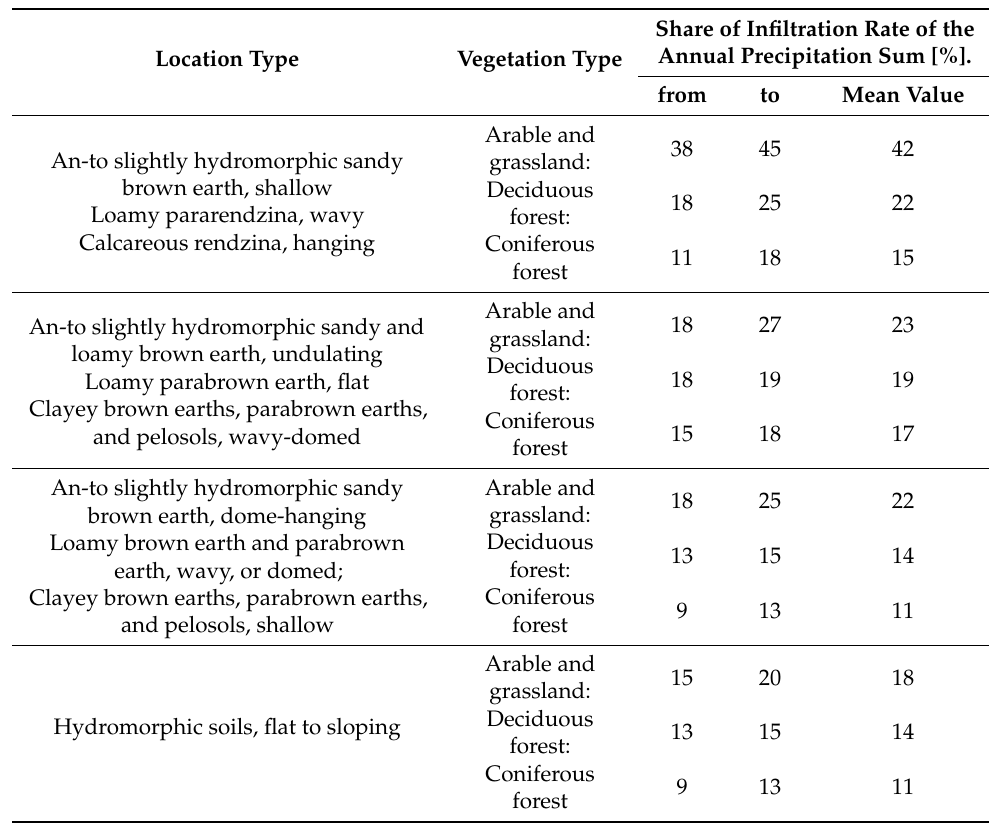
Table 10. Reference value ranges and mean values for the ratio of infiltration rate of the annual precipitation total [%] depending on soil type, relief, and vegetation [41]. Share of Infiltration Rate of the Annual Precipitation Sum Location Type Vegetation Type